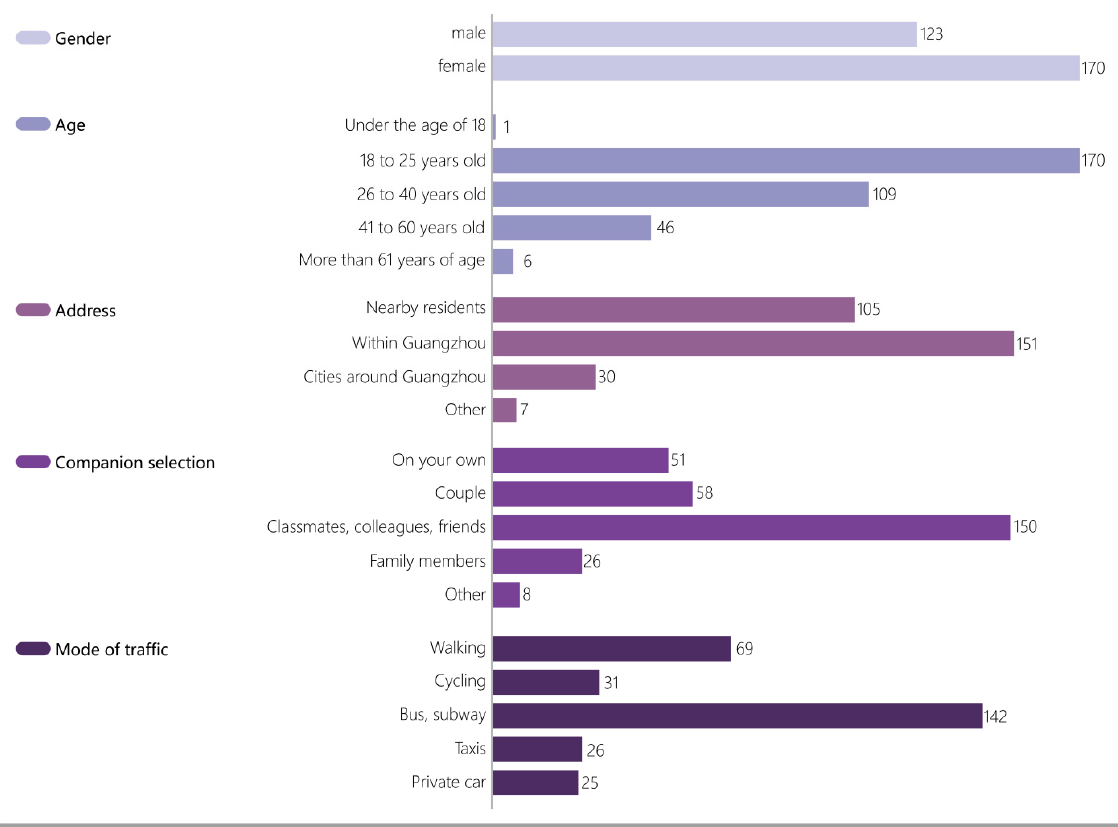
Figure 10. Information on residents interviewed.